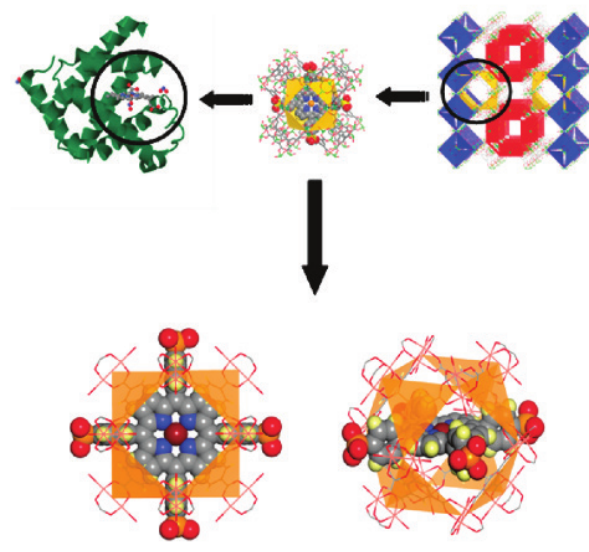
Figure 9: (Top) Encapsulation of Fe(III)/Mn(III)TSPP into octahemioctahedral cage of HKUST-1 framework and its structural resemblance to a haemoprotein; (bottom) two of the three equivalent orientations of Fe(III)/Mn(III)TSPP encapsulated in HKUST-1 [110]. Reprinted with permission from Ref. [110].